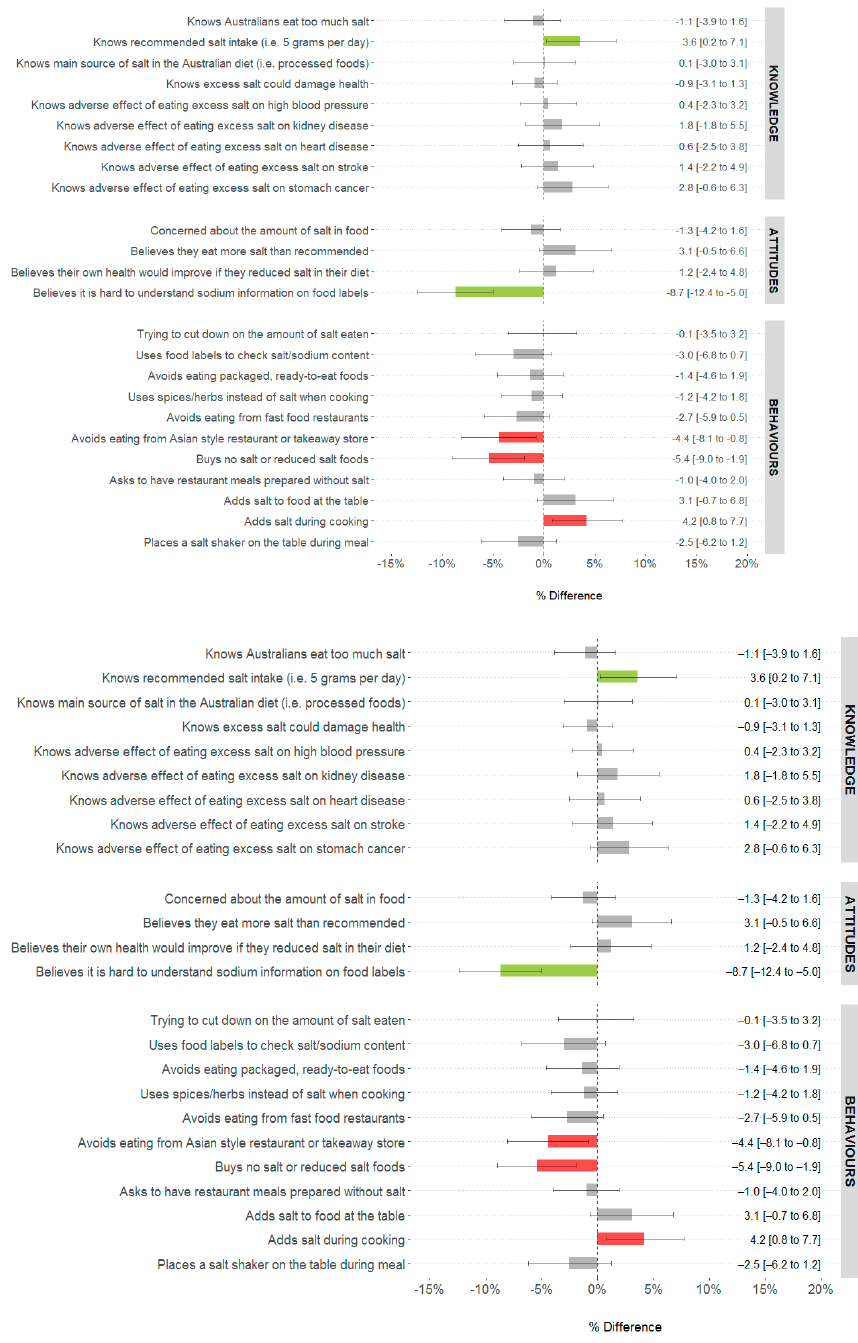
Figure 4. Difference in knowledge, attitudes and behaviors related to dietary salt among wider adult sample without children aged <18 years residing in the state of Victoria, Australia following a salt